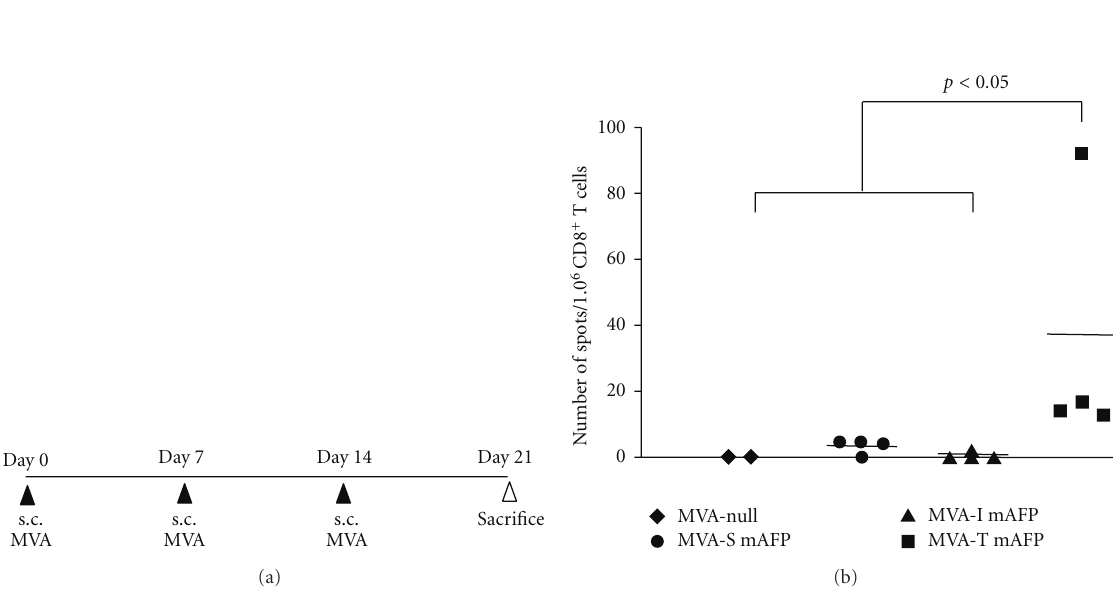
Figure 2: AFP-specific CD8 + T-cell immune response after vaccination of C3H/HeN mice with MVA-s mAFP, MVA-I mAFP, or MVA-T mAFP. (a) Schematic of the experimental design; (b) IFN γ ELISpot assay, CD8 + T cells from mice vaccinated with MVA-null ( (cid:2) : negative control) or MVA expressing the secreted ( (cid:2) ), the intracellular ( (cid:3) ), or the transmembrane ( (cid:4) ) form of murine AFP protein were stimulated in vitro by a specific AFP peptide. Statistical analyses were performed by the Kruskal-Wallis